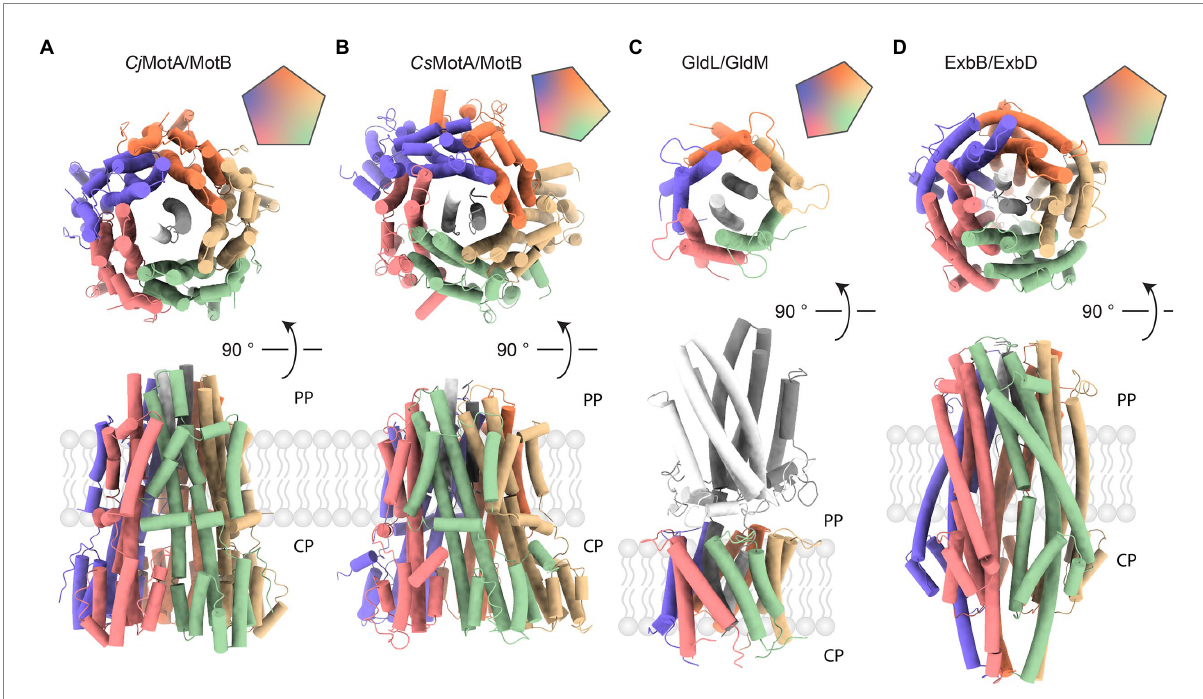
FIGURE 3 Comparison of complexes with 5:2 stoichiometry. Vertical (top) and horizontal (bottom) views of protein complexes with 5:2 stoichiometry. Assembly symmetry is represented by the top right insert. PP stands for periplasm, CP indicates cytoplasm. (A) MotA/B complex from a Gram- negative Campylobacter jejuni (PDB ID: 6YKP). (B) MotA/B complex from a Gram-positive Clostridium sporogenes (PDB ID: 6YSF). (C) GldL/M complex from a Gram-negative Flavobacterium johnsoniae (PDB ID: 6YS8). The periplasmic domain is shown in gray. (D) ExbB/D complex from a Gram-negative Serratia marcescens (PDB ID: 7AJQ). ExbB (colored) accommodates two helices from ExbD (shades of gray) that serve as a rotational